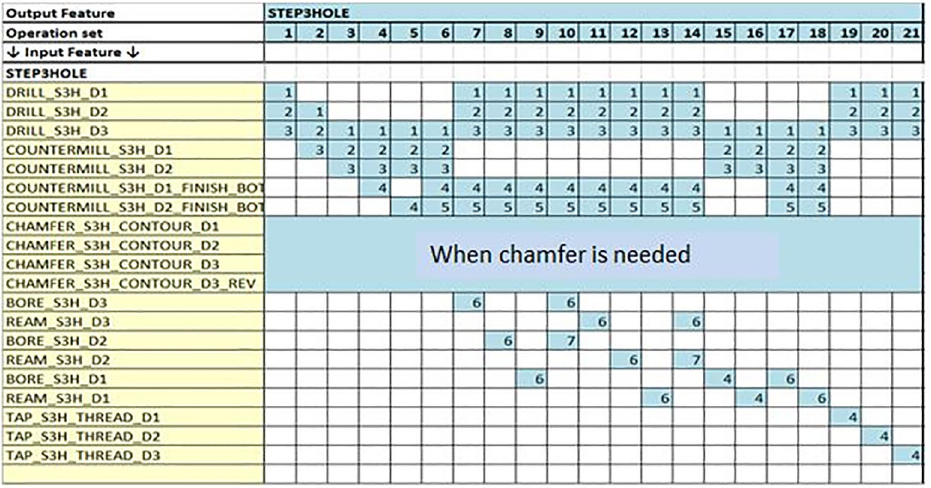
Fig. 5. Selecting the machining technology according to the feature.